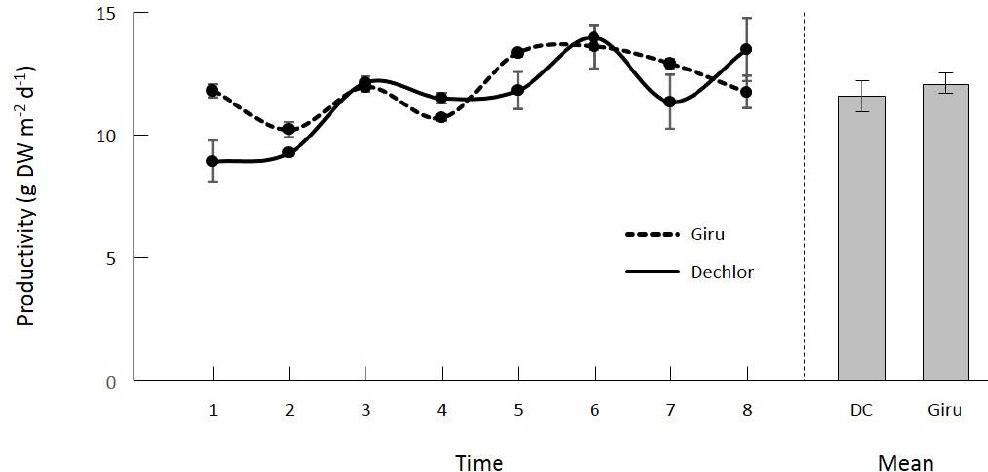
Figure 1. Mean productivity (g DW m −2 day −1 ) of Oedogonium in dechlorinated water and Giru waste water over the course of the initial 8 week experiment. Data show mean productivities ± standard error ( n = 5) for each time point. The experiment wide mean productivity is also shown for each treatment by the columns (“DC” = dechlorinated water). The error terms for the columns are based on the error associated with the mean productivity in each of the 8 weeks. Table 1. Mass balance of Al sequestration in Experiment 1. The data shows the mean initial and final concentration of Al in the waste water after each 7-day cultivation window, the amount of biomass produced, and the concentration of Al in the Oedogonium biomass from each week. From this data a mass balance model was derived, with approximately 90% of the Al removed from the waste water each week being accounted for in the harvested Oedogonium